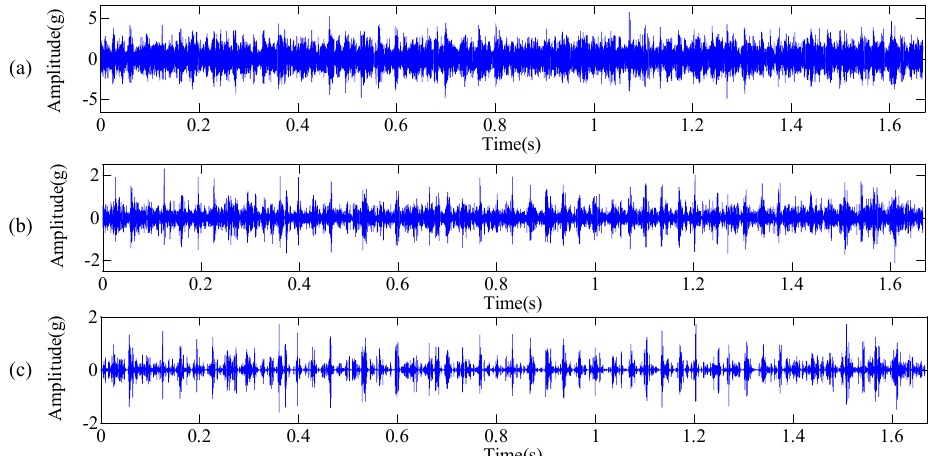
Figure 7. In 95 h: ( a ) Raw vibration signals; ( b ) reconstructed component via Dual − BP; ( c ) reconstructed component via MCA.